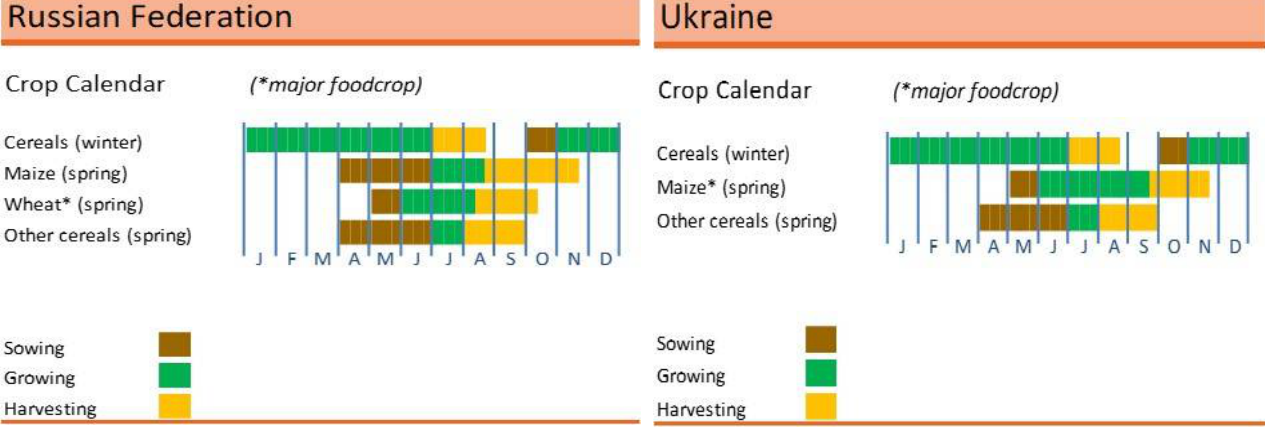
Global food prices showed an increasing trend between May 2017 and May 2022 (Figure 5). From 2017 to 2019, global food prices had a history of stability. However, food prices began to rise in 2020 and 2021. Wheat and maize prices increased each month dramatically by 2.17% and 2.59%, respectively. During the same period, the price of soybeans increased by 1.73% per month [28].